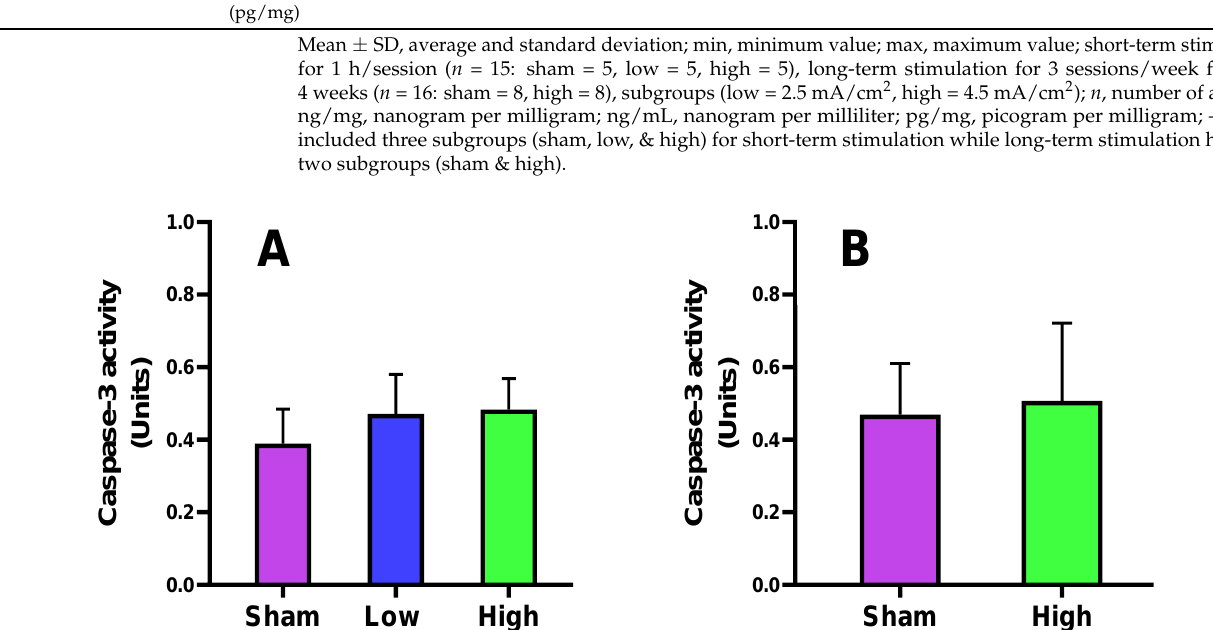
Figure 1. Effect of tDCS-iTBS on caspase-3 activity: ( A ) short-term ( n = 15) and ( B ) long-term stimulations ( n = 16).